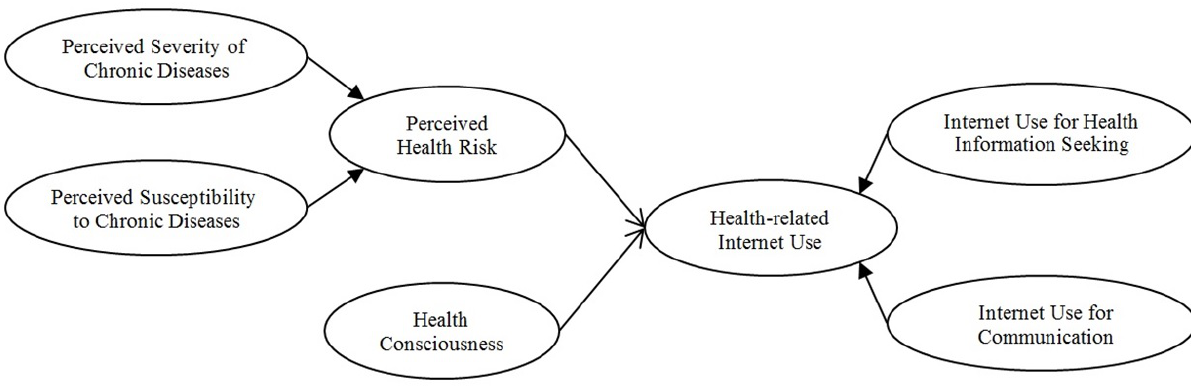
Figure 1. Hypothesized model based on the Health Belief Model.